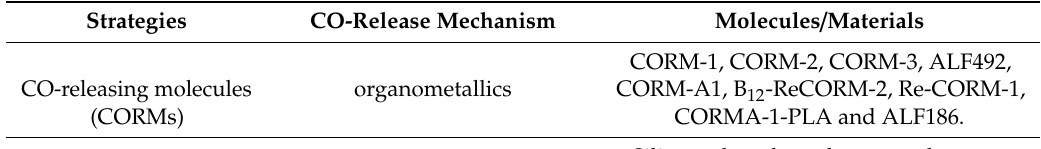
Table 3. Summarize the CO-releasing substrate along with their